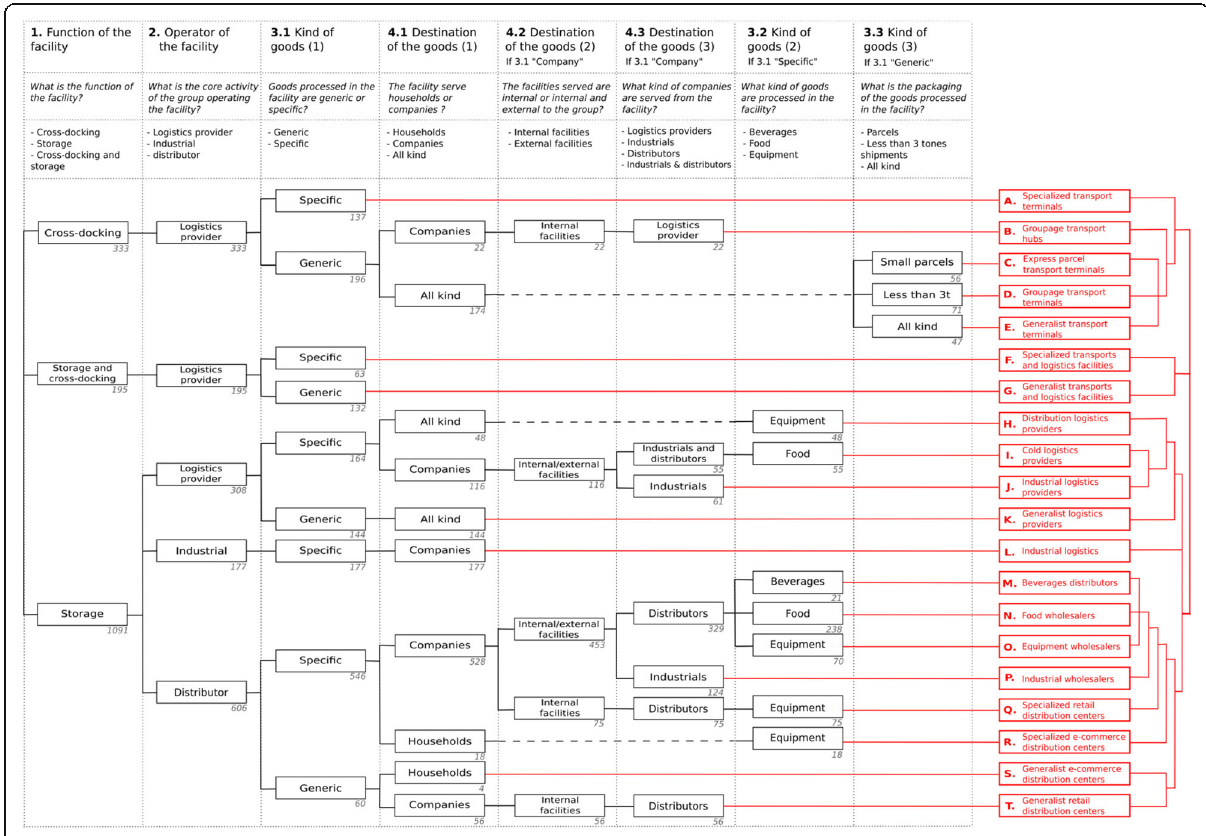
Fig. 2 General framework of the typology of logistics facilities (source: